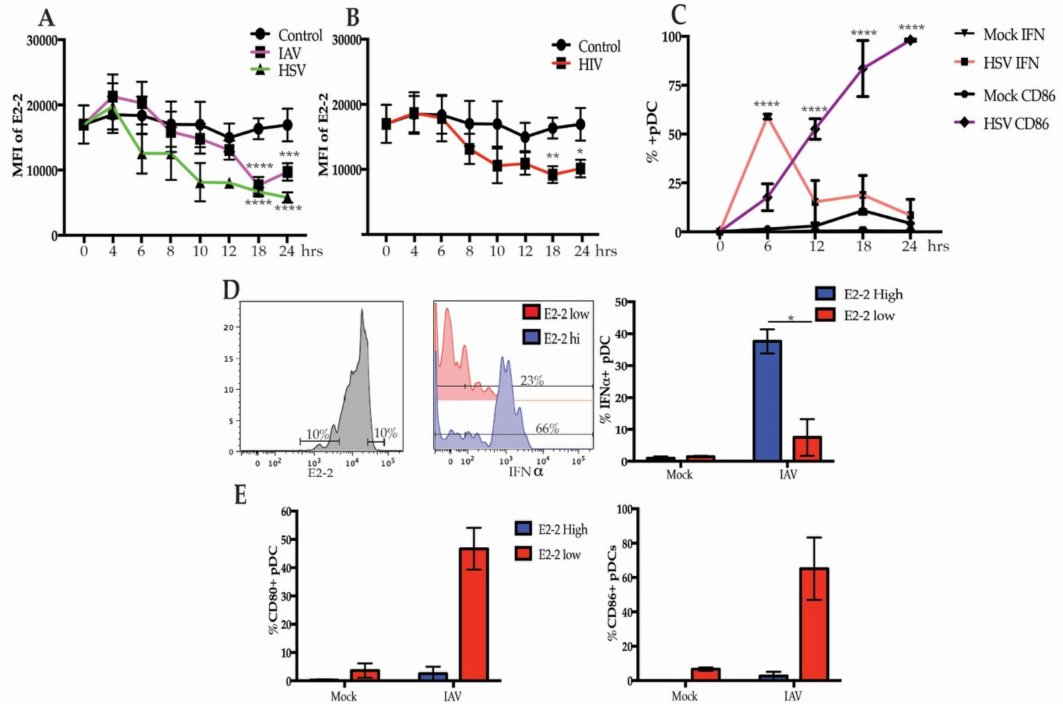
Figure 2. E2-2 expression after viral stimulation is associated with functional and phenotype di ff erences. ( A , B ) Expression of E2-2 in pDCs after PBMCs were stimulated with herpes simplex virus type 1 (HSV) or influenza A virus (IAV) at a multiplicity of infection (MOI) of 1 ( A ) or 500 ng p24 equivalents / mL of HIV-MN ( B ); n = 5 independent experiments. ( C ) pDCs stimulated with HSV for 0–24 h were measured for intracellular IFN α and CD86 expression by flow cytometry, n = 3 independent experiments. ( D , E ) Gating strategy to compare the 10% highest and lowest E2-2 expressing pDCs after stimulation with IAV for 24 h. Comparison of the percent IFN α + cells ( D ) and CD80 + and CD86 + ( E ). ( D , E ), n = 4 independent experiments. Data are presented as means ± SEM. p values < 0.05 were considered significant. * p < 0.05, ** p < 0.01, *** p < 0.001, **** p <